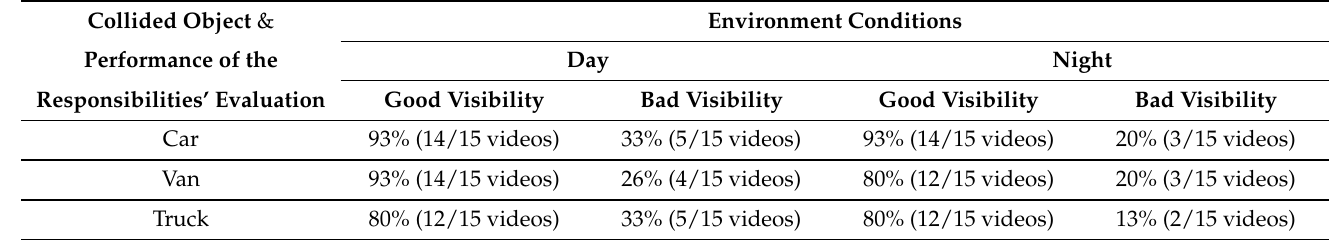
Table 3. Results of the module in evaluating responsibilities with user’s manual selection.